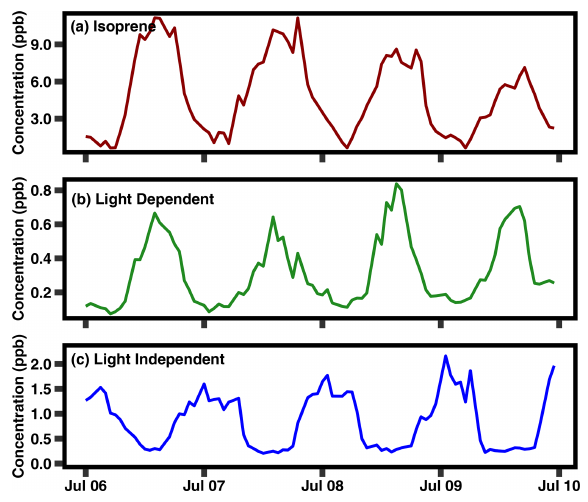
Table 1. Percent of concentrations attributed to light-independent (LIF) and light-dependent (LDF) emissions between